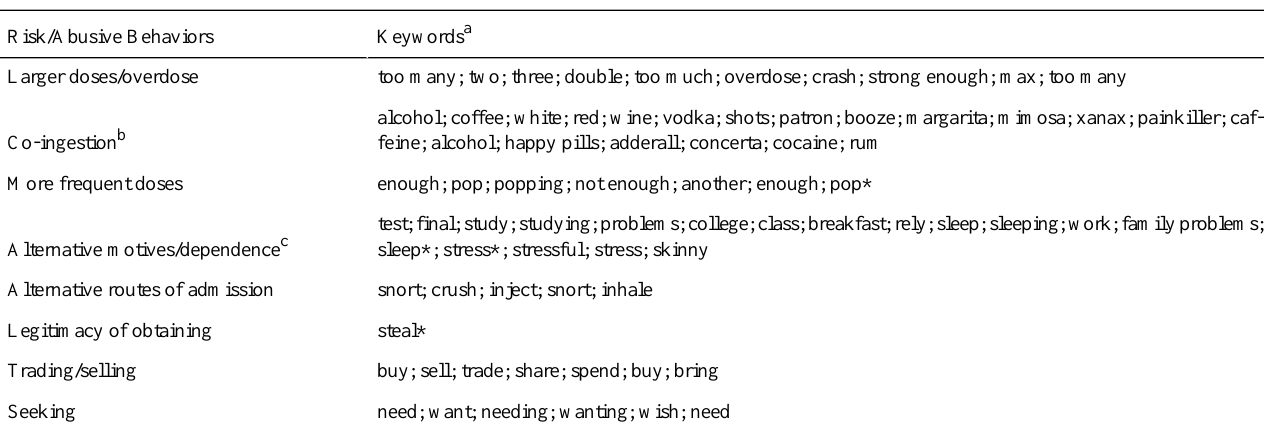
Table 2. Keywords for risk/abusive behaviors.